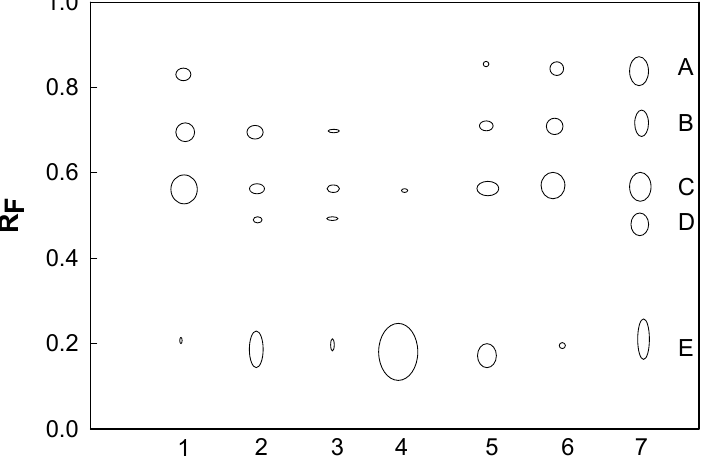
FIGURE 1. TLC separation of chicken embryo BMF treated with PLA 2 and/or L- α - lysophosphatidylcholine. The schematic presentation is based on analyses of